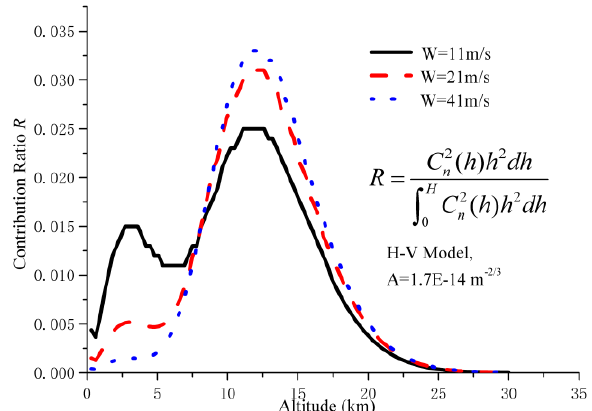
Figure 3. Contribution of turbulence at each part of the path to the turbulence moment of second order in H-V (Hufnagel-Valley) model; parameter A means the turbulence strength at ground layer, W (with units of m/s) controls the high-level turbulence [1].